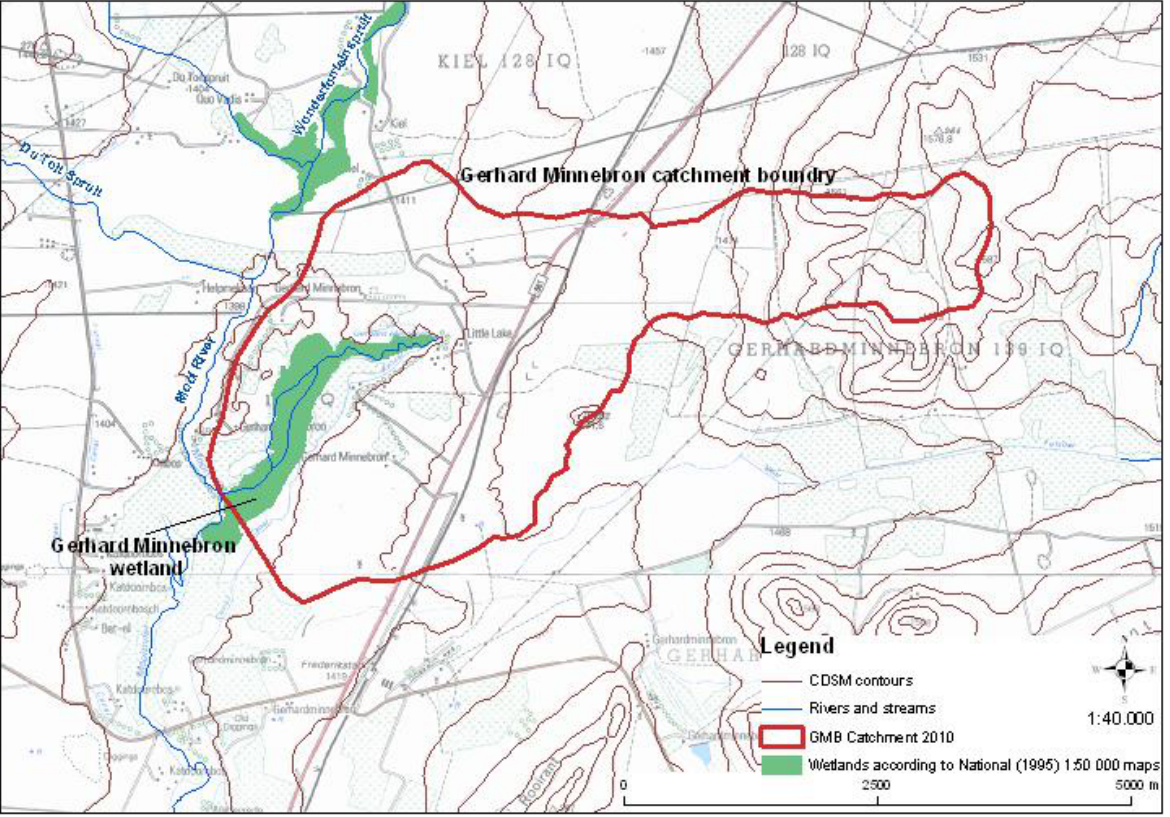
Figure 26. Surface catchment area of the Gerhard Minnebron wetland (GIS: